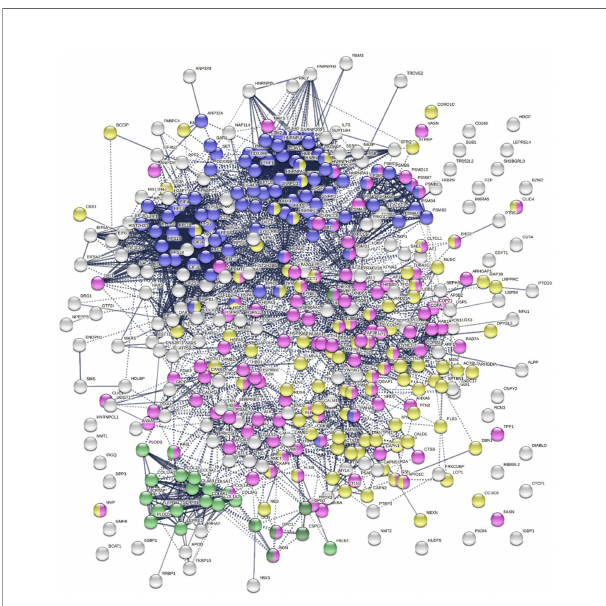
FIGURE 1 | The 408-protein autoantigen-ome identi fi ed by DS-af fi nity from HFL1 cells forms a highly interacting network. Connecting lines represent interactions with high con fi dence (minimum interaction score of 0.7) as per STRING analysis. Colored proteins are involved in metabolism of RNA (blue), vesicles (pink), cytoskeleton (gold), collagen and elastic fi bers (light green), and chondroitin sulfate/dermatan sulfate metabolism (dark green).